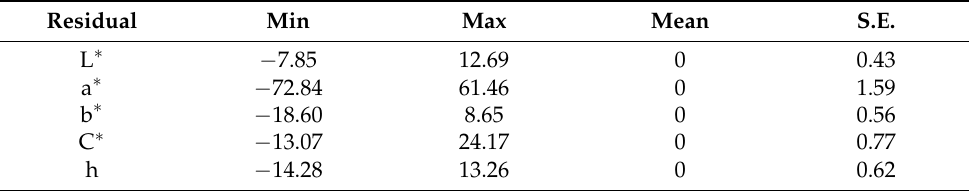
Table 4. Residual of the regression